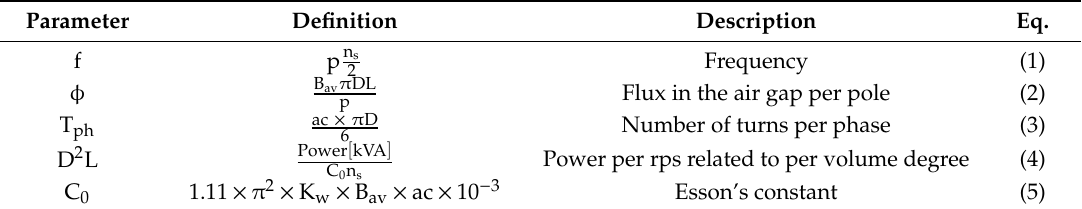
Table 1. Fundamental parameters of motor design.